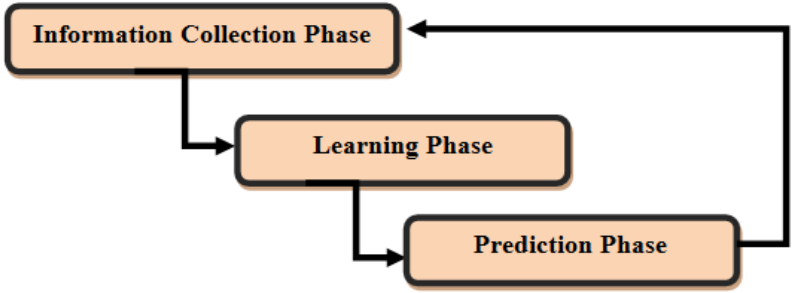
Figure 4. The learning-based assessment